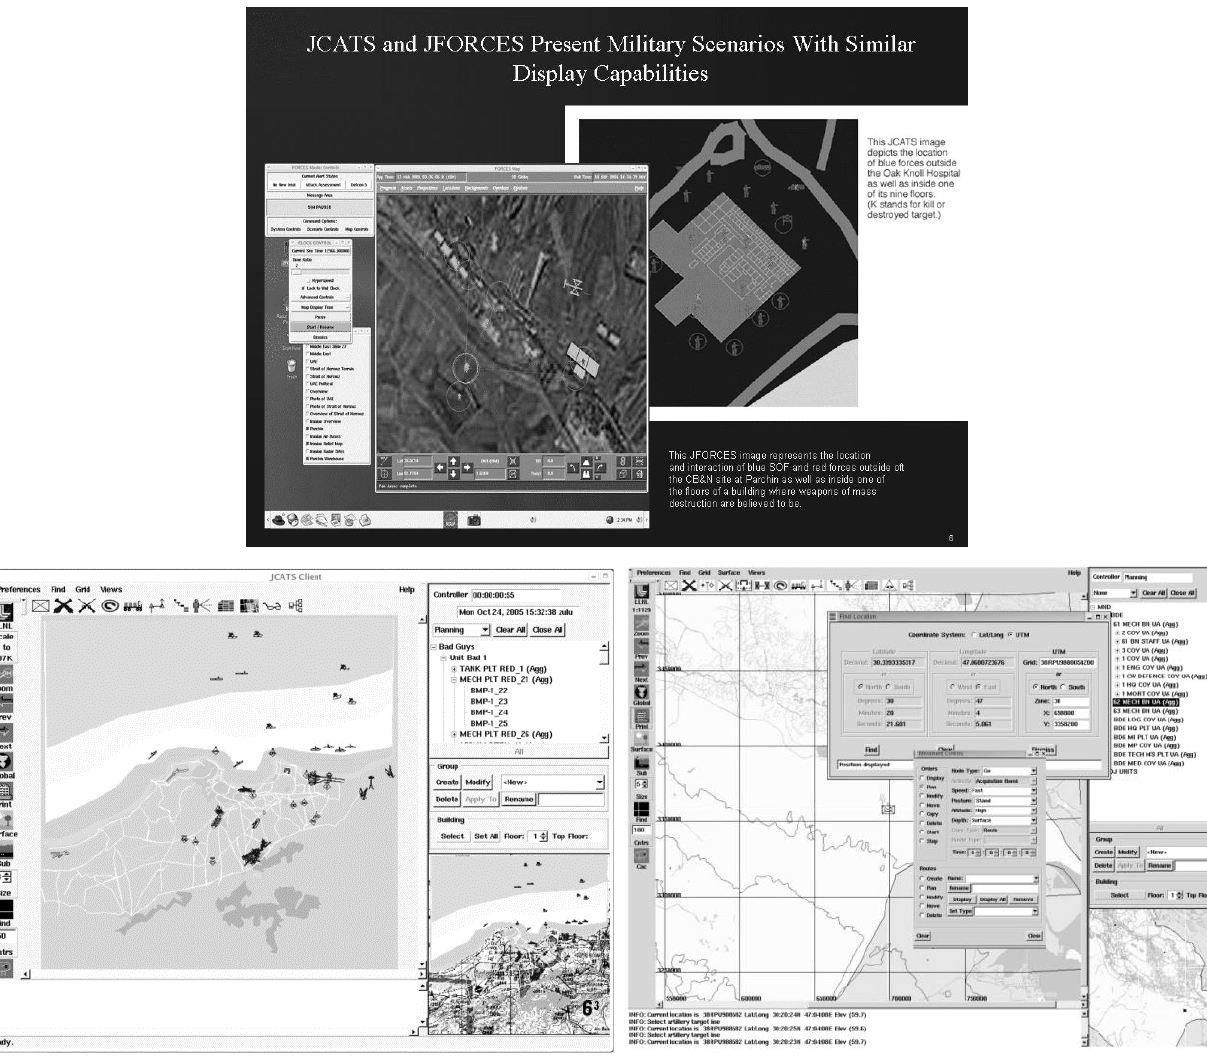
Figure 6. JCATS graphical